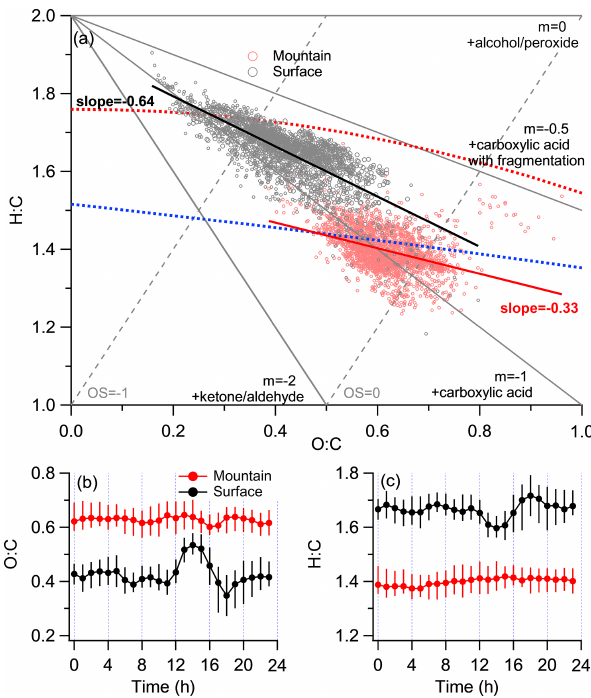
Figure 5. Characterization of elemental ratios at both surface and mountain sites. (a) The standard Van Krevelen triangle diagram of H : C versus O : C. (b) Diurnal variations in O : C. (c) Diurnal vari- ations in H : C. The gray and red circles denote the data points from the surface and mountain sites,